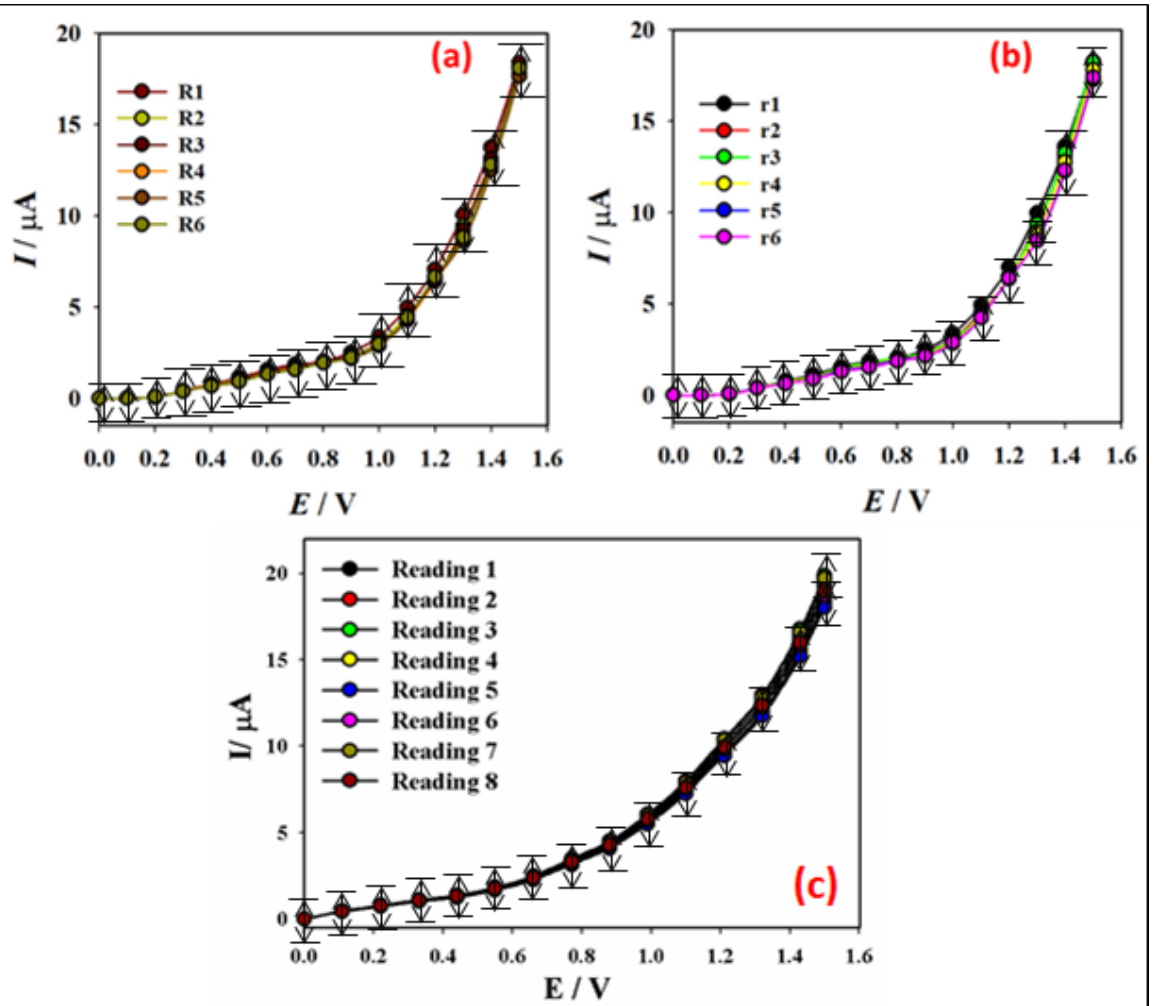
Figure 7. ( a ) Repeatability using different WE (0.1 µM, 25.0 µL Hg 2+ ion; 5.0 mL, 0.1 M PBS at